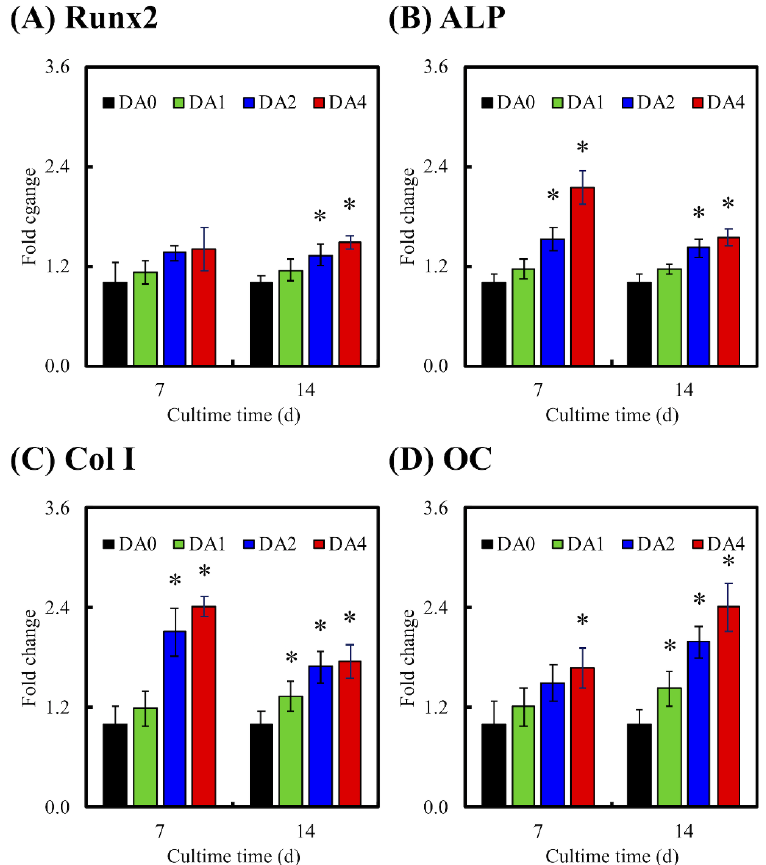
Figure 10. The ( A ) Runx2; ( B ) alkaline phosphatase (ALP); ( C ) Col I; and ( D ) OC gene expression in the WJMSC were cultured on PDA-coated CS cement for 7 and 14 days. “*” indicates a significant difference ( p < 0.05) compared to DA0.